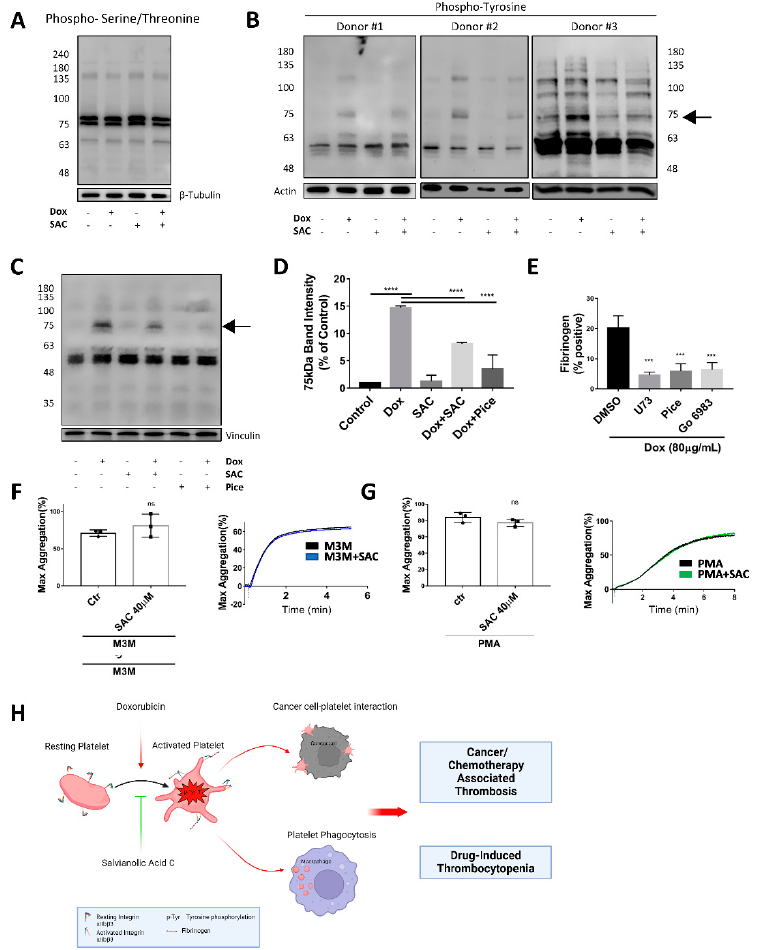
Figure 5. SAC Ameliorated Dox-Induced Tyrosine Phosphorylation of Platelet Proteins. Human gel-filtered platelets were pretreated with SAC (10 µM) or SYK protein inhibitor piceatannol (10 µg/mL) for 2 minutes before incubation with Dox (40 µg/mL) for 20 minutes. Total platelet lysate for each group was resolved with SDS-PAGE and probed with anti-phosphoserine/threonine ( A ) or anti-pY ( B , C ) antibody. β -tubulin, actin, and vinculin served as loading controls. ( D ) Quantification of band intensity for 75 kDa protein in preceding Western blots. ( E ) Effects of PLC inhibitor U-73122 (2 µM), Syk inhibitor piceatannol (20 µg/mL), or PKC inhibitor Go 6983 (10 µM) on Dox-induced murine platelet Fg binding. ( F , G ) SAC (40 µM) on PLC agonist m-3M3FBS (400 µM) and PKC agonist PMA (50 ng/mL) induced human washed platelet aggregation. Aggregation traces are representative of data from at least three independent experiments. ( H ) Schematic summary of novel mechanism for doxorubicin-associated thrombosis and drug-induced thrombocytopenia. Dox induced integrin α IIb β 3 activation and subsequent fibrinogen binding, possibly through upregulated intracellular tyrosine phosphorylation. As a result, Dox could amplify cancer-platelet interaction and facilitate cancer/chemotherapy-induced thrombosis. Dox-treated platelets were also cleared more rapidly by phagocytosis. Salvianolic acid C inhibited Dox-induced platelet activation/cancer-platelet interaction/phagocytosis, which are contributing factors for Dox-associated thrombosis and throm- bocytopenia. Created with BioRender.com. n ≥ 3 for all experiments. Data displayed as mean ± SD. Statistical significance determined by one-way ANOVA ( D , E ) or paired t -test ( F , G ). (*** p < 0.001, and **** p < 0.0001, ns = not significant). U73 = U-73122, Pice = piceatannol, pY = phosphotyrosine, M3M =